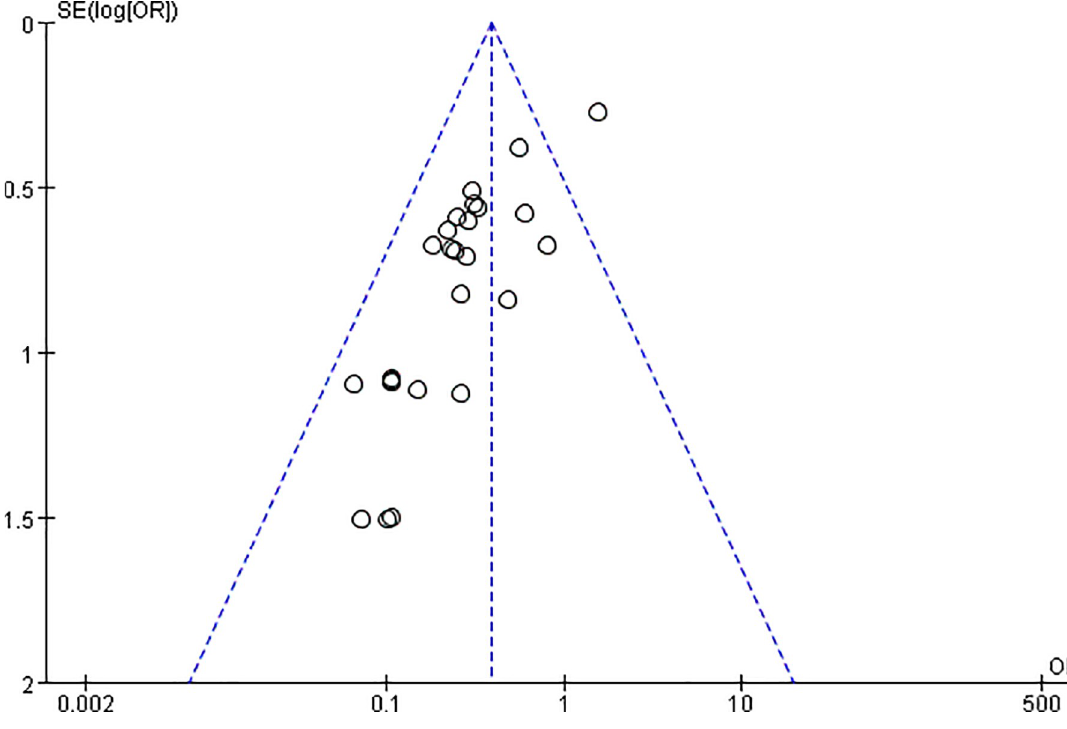
Fig 2. The funnel plots of the publication bias calculated from the Begg’s